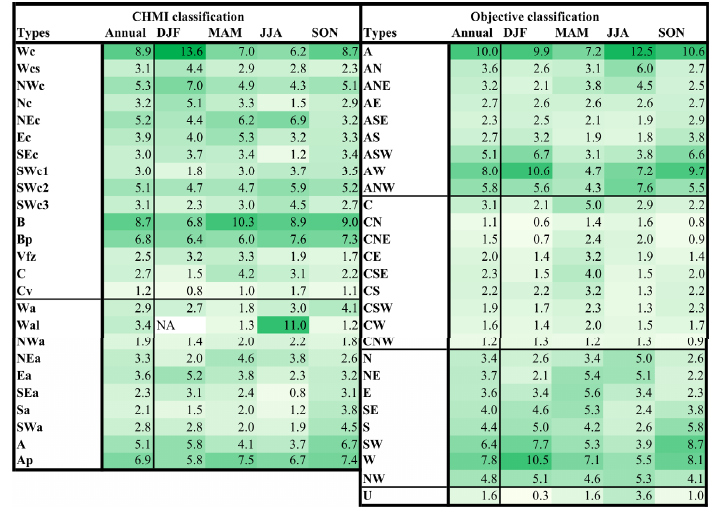
Figure 4. Relative annual and seasonal (DJF: December–February; MAM: March–May; JJA: June– August; and SON: September–November) occurrence frequencies (%) of the individual circulation